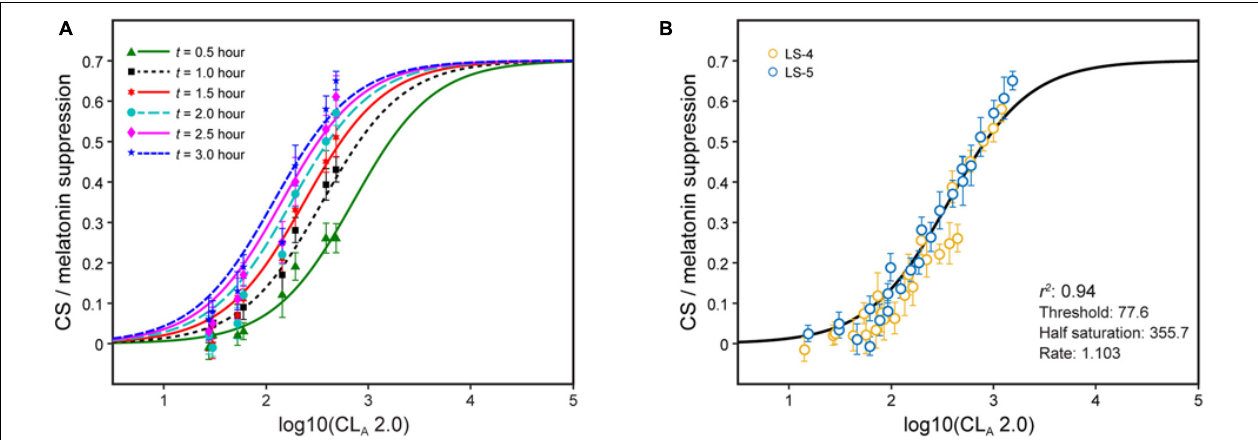
FIGURE 4 | Nocturnal melatonin suppression following different continuous light exposure durations (A) and after modifying the half-saturation constant by applying Eq. 2 (B) . The legend entries in panel B correspond to the light source designations in Supplementary Table 1 and Supplementary Figure 1 ; blue symbols are associated with light sources where b-y > 0 and yellow symbols for light sources where b-y ≤